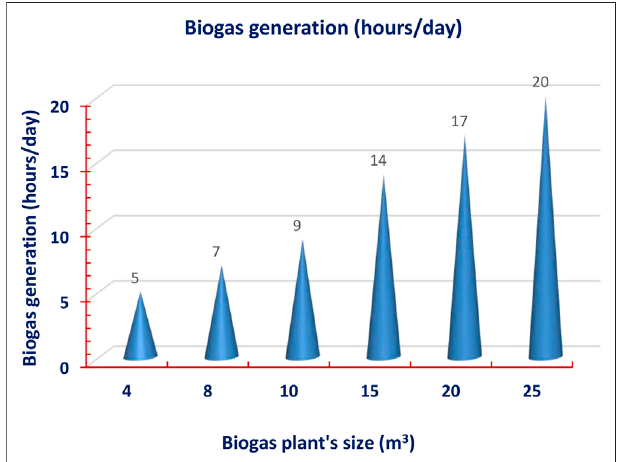
FIGURE 1 | Biogas production with respect to various sizes of biogas plant. Source: Authors ’ elaborations based on data from biogas plant